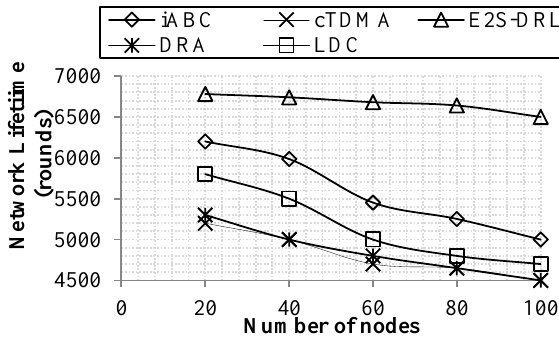
Figure 4. Comparison of network lifetime vs. the number of nodes.